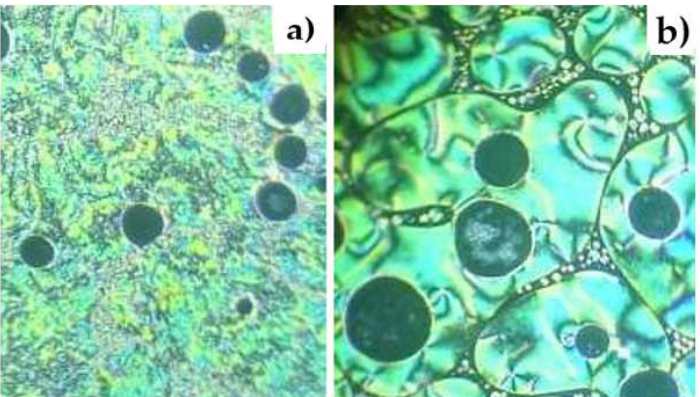
Figure 3. Nematic texture under polarized optical microscopy (POM) upon heating ( a ) for B at 123 °C and ( b ) for C at 130 °C, with heating rate of 10.0 °C / min.